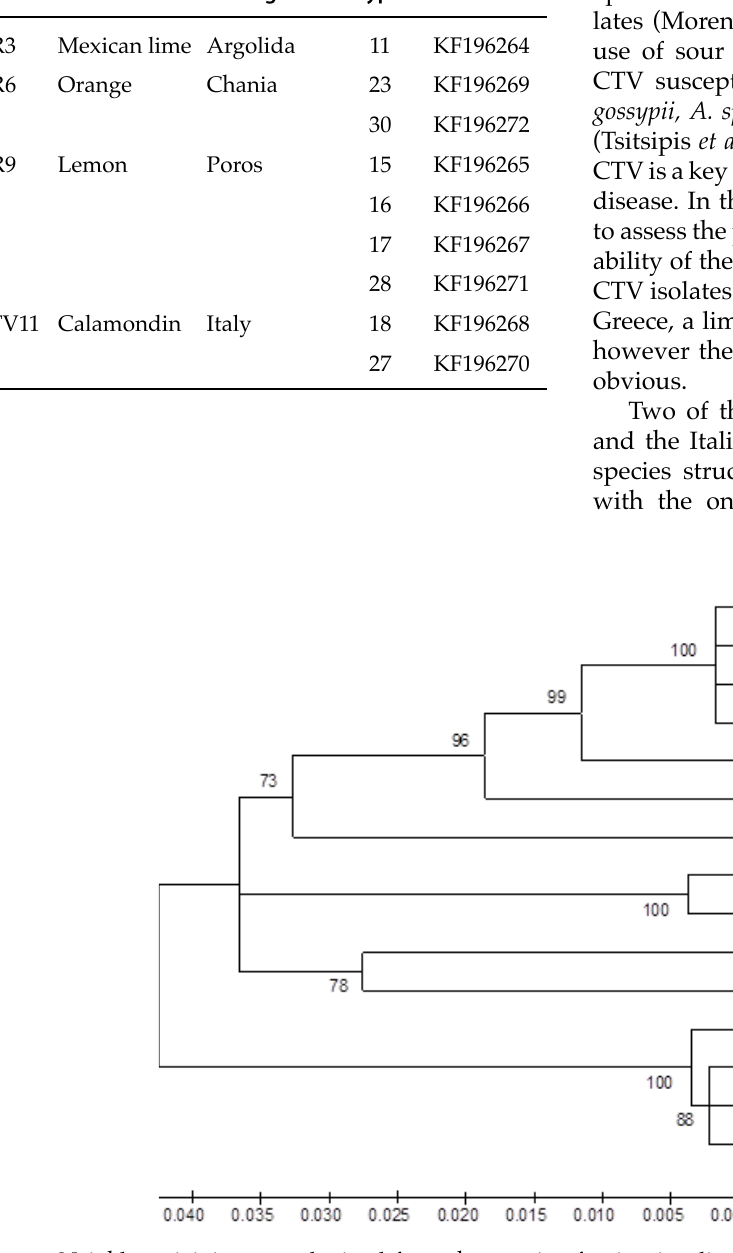
Figure 2. Neighbour-joining tree obtained from the matrix of pair-wise distances (nucleotide, Kimura 2-parameter) be- tween the CP gene sequences of nine isolates of Citrus tristeza virus (CTV) from Greece and Italy. Bootstrap values obtained from 1000 replications are presented. Nodes with bootstrap values lower than 70% are not individualized. Group names as proposed by Nolasco et al. (2009) are indicated on the right. Nucleotide distance is represented in the horizontal